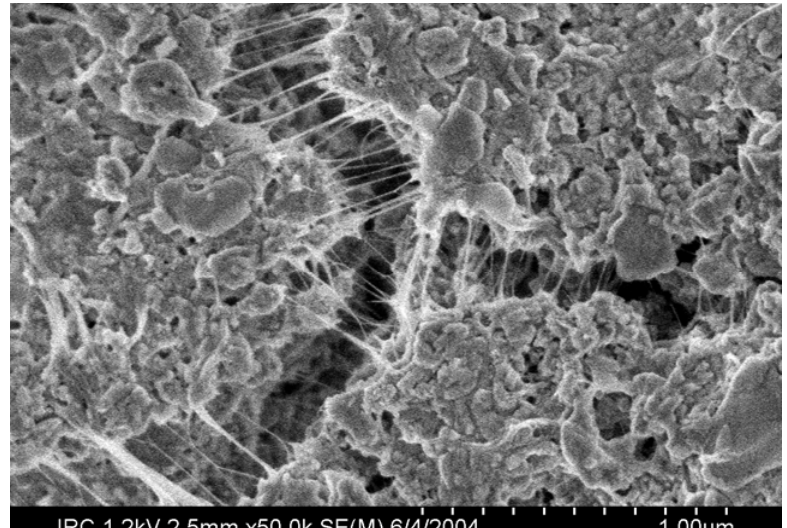
Figure 9. Example of crack bridging in a SWCNT/hydrated OPC composite bridging structures are SWCNT